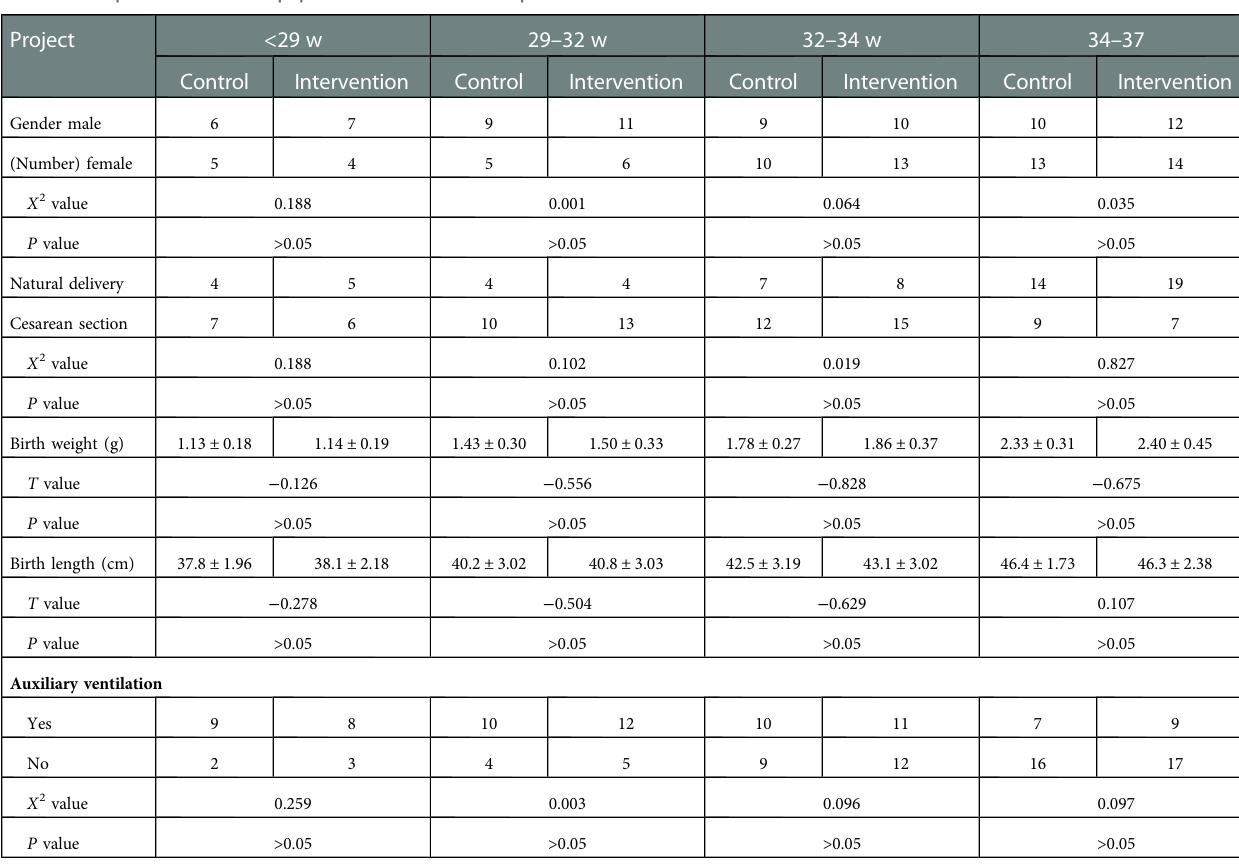
TABLE 1 Comparison of baseline population characteristics of preterm infants.